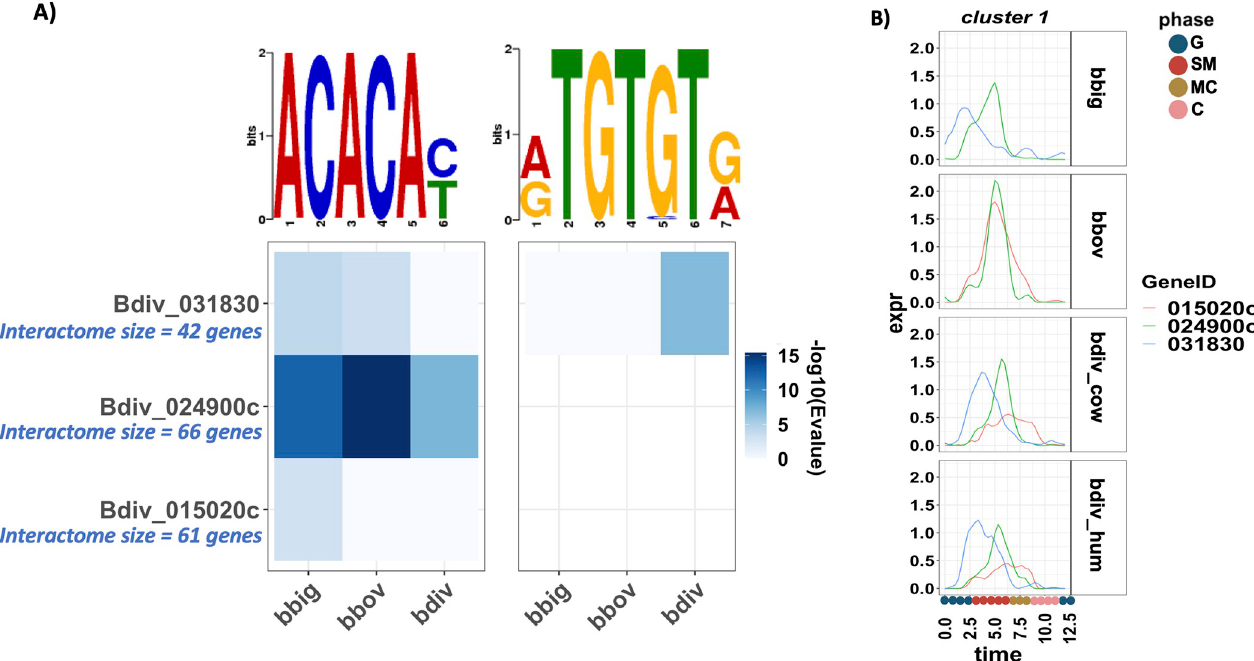
Fig 9. Motif search analysis identified a significant motif in the promoter of the interactome of 3 AP2s. (A) The heatmap shows the significance ( − log10(E- value)) of identified motifs, with rows corresponding to the interactome of the indicated AP2 and columns corresponding to the species. (B) Expression curve of the 3 AP2s. Data and code for generating the figure are available at https://github.com/umbibio/scBabesiaAtlases.